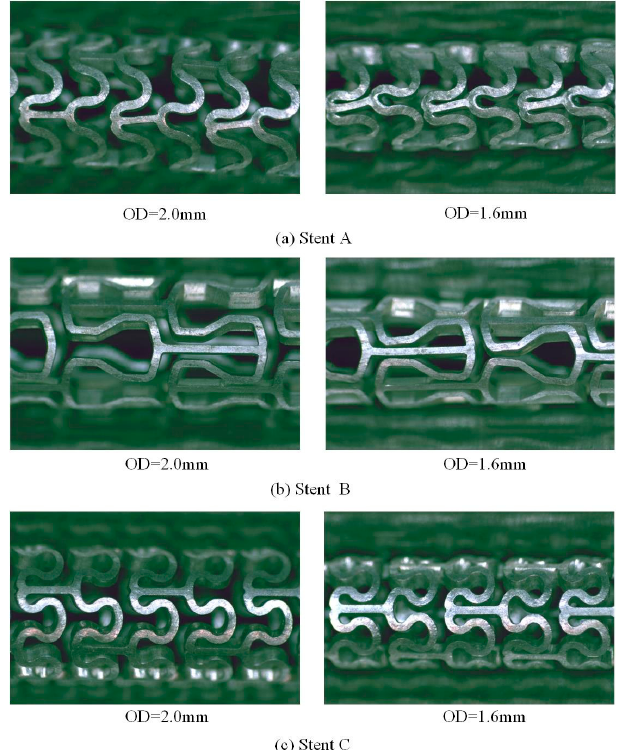
Figure 12. Experimental profiles of ( a ) Stent A, ( b ) Stent B, and ( c ) Stent C after crimping to outside diameters of 2.0 and 1.6 mm. diameters of 2.0 and 1.6